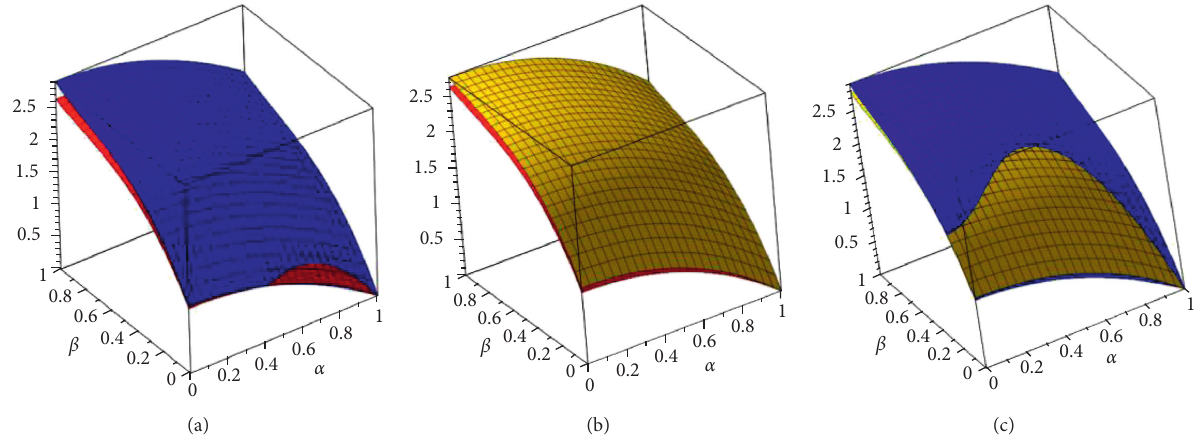
Figure 11: V functions of 􏽥 A and 􏽥 B , 􏽥 A and 􏽥 C , and 􏽥 B and 􏽥 C from Chutia and Saikia’s [25] method. α , β